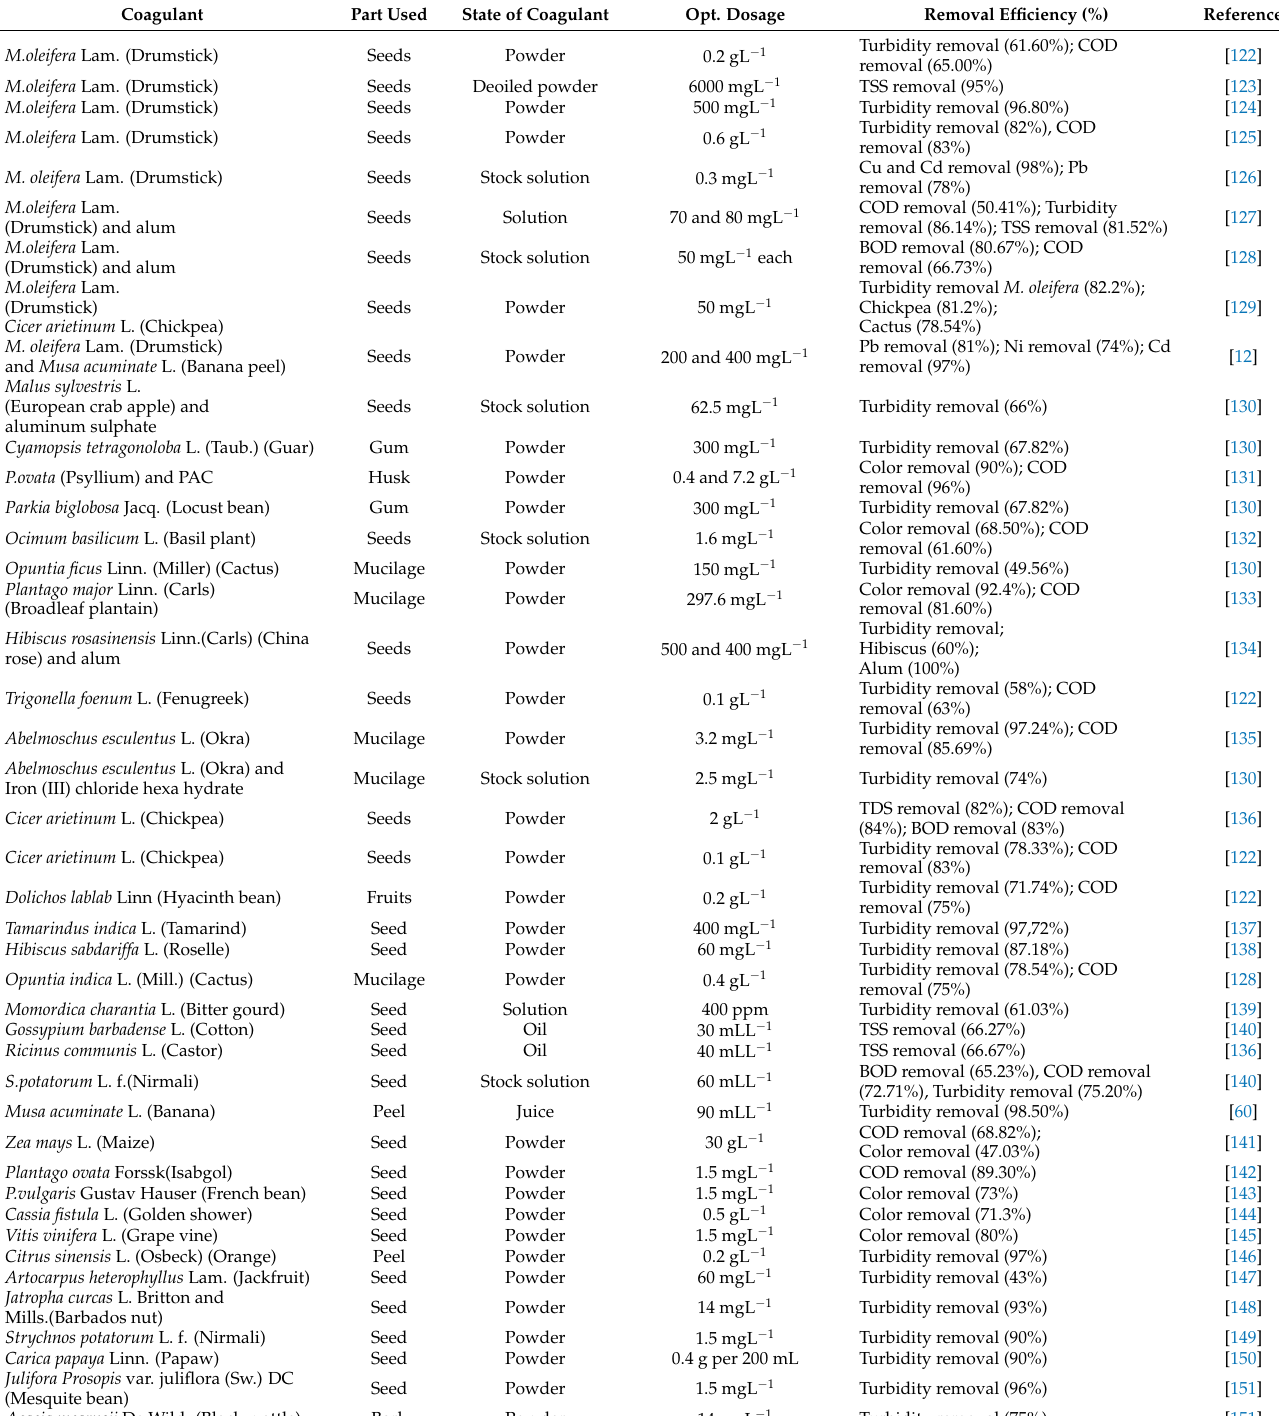
Table 2. Plant-based natural coagulants used in the treatment of polluted